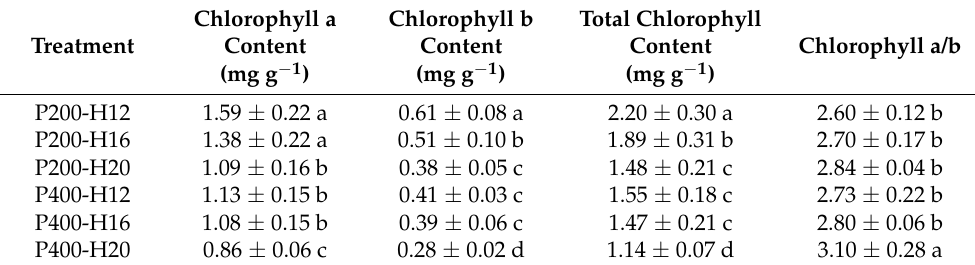
Figure 4. Photon yield based on ( A ) fresh and ( B ) dry weights of cucumber seedlings grown under different daily light integrals (DLIs) at 6, 11, 16, and 21 days after sowing (DAS) in a closed transplant production system. Data are indicated as mean ± standard deviation. Different letters indicate significant differences at p < 0.05. Table 2. Influence of photosynthetic photon flux density (P) and photoperiod (H) with different daily light integrals (DLIs) on pigment content of cucumber seedlings grown for 21 days in a closed transplant production system.